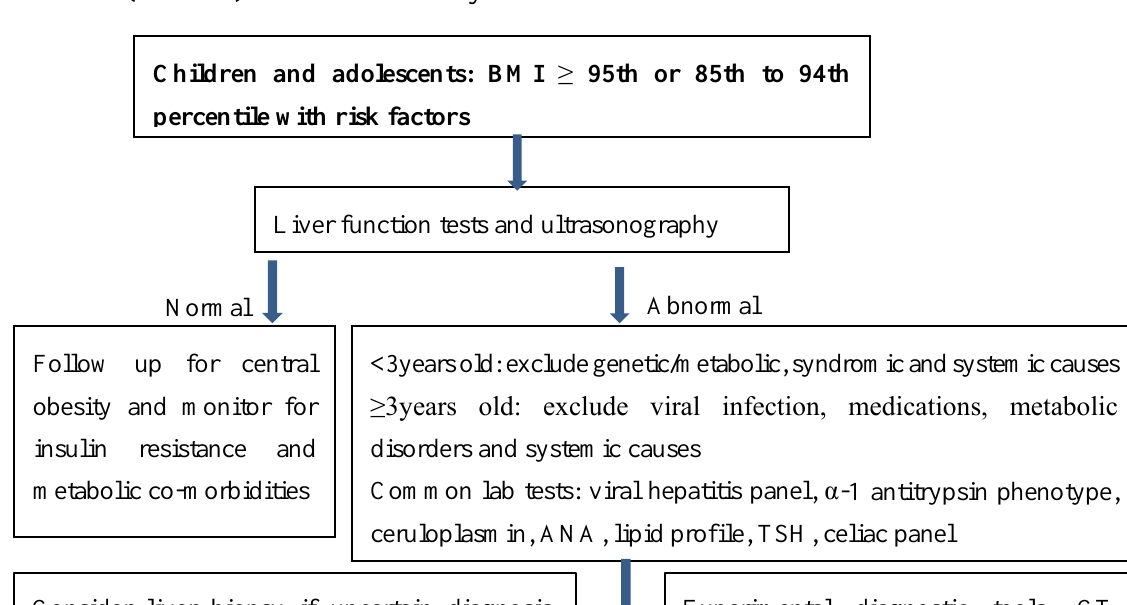
Figure 2. Management algorithm for children with suspected non-alcoholic fatty liver disease (NAFLD). UDCA: ursodeoxycholic